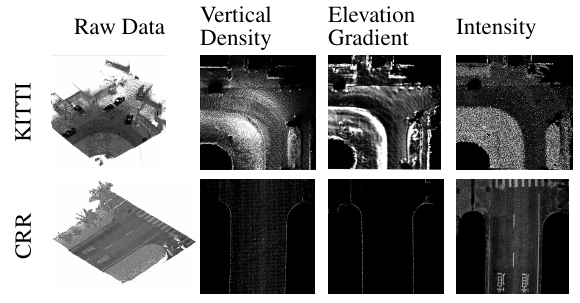
Table 2. The visualization results of the multiple feature maps on millimeter-level (CRR) and centimeter-level accuracy (KITTI) LiDAR